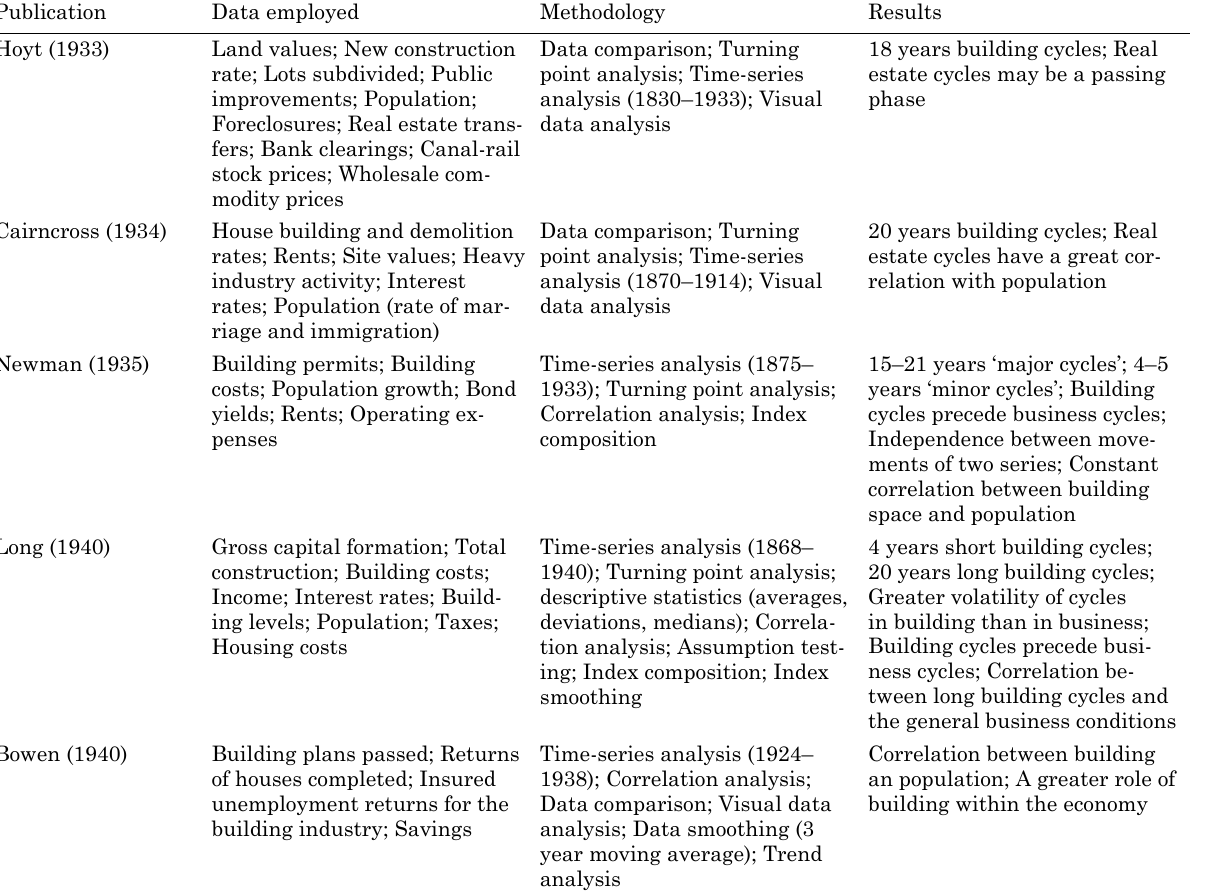
table 1 . Key ‘early era’ publications on property